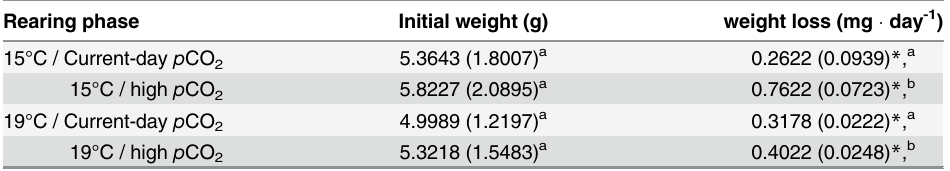
Table 3. Concholepas concholepas. Initial dry weight (g) and effects of contrasting rearing conditions tem- perature (15 and 19°C) and p CO 2 (500 and 1400 μ atm) levels on the mean ( ± SE) temporal dry weight losses (mg (cid:1) day -1 ) in naked shells after 1 month of rearing in the experimental conditions. The measurements were done on 4 shells at the beginning of the experiment and the after 1 month of rearing under the contrasting con- ditions of p CO 2 and temperature. The initial weight of naked shell assigned to each experimental temperature and p CO 2 conditions were compared by 1-way ANOVA. Similar superscripts indicate lack of significant differ- ences between treatments (p > 0.05). Weight losses were compared by 2-way ANOVA.